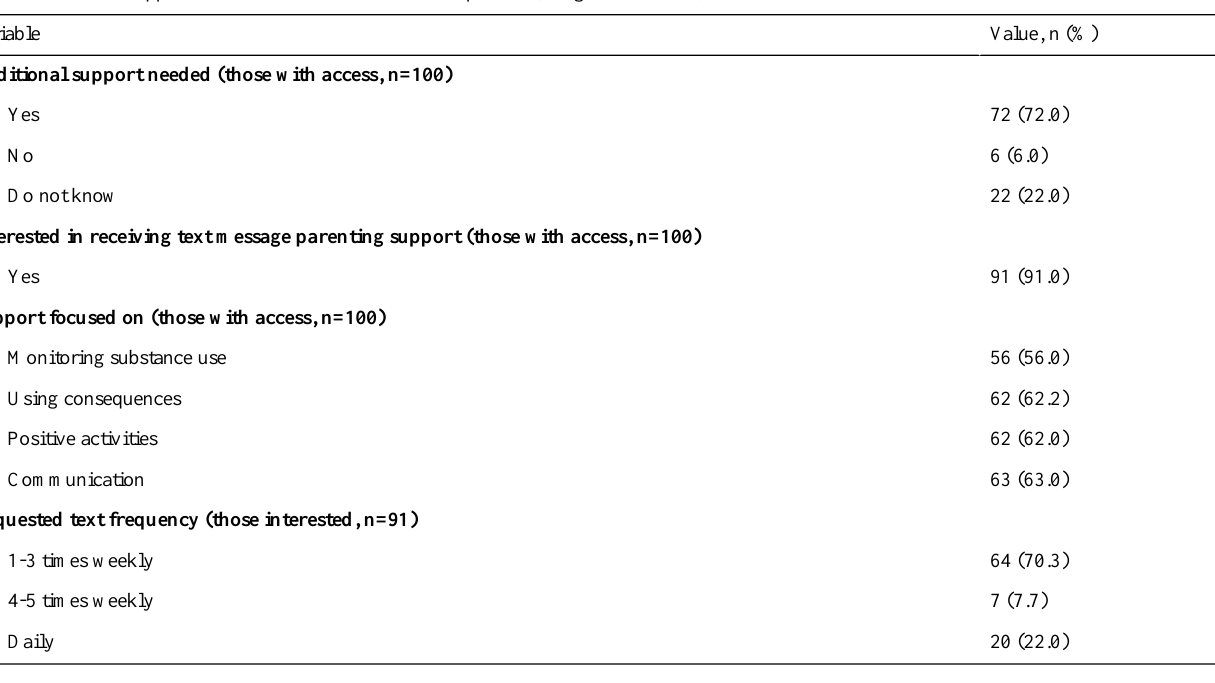
Table 3. Aftercare support and clinic calls made to mobile phones (caregiver variables).